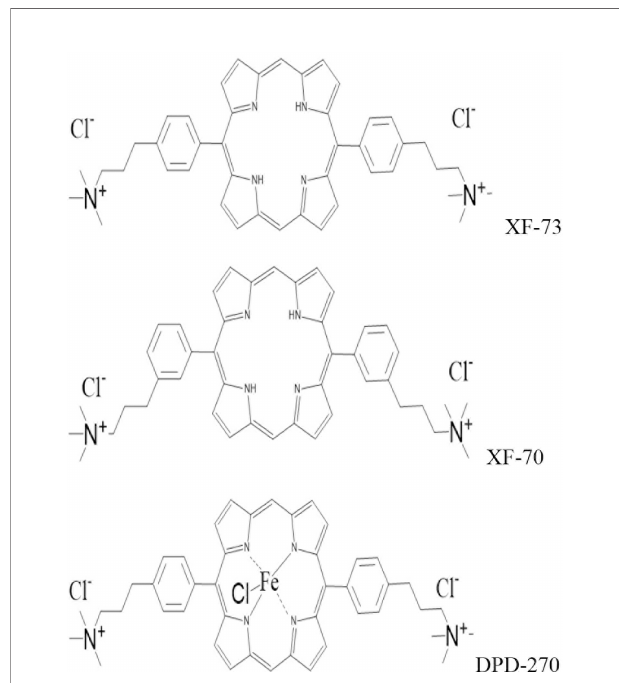
FIGURE 1 | Chemical structures of the studied